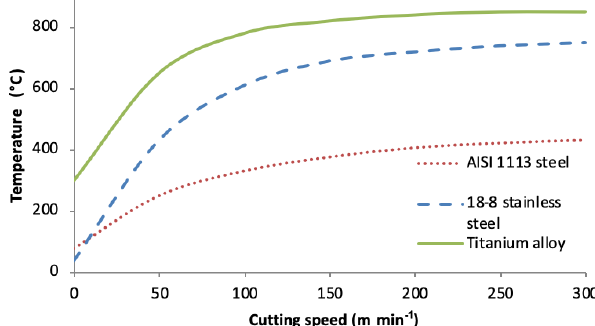
Table 5. Measured responses during experimentation.